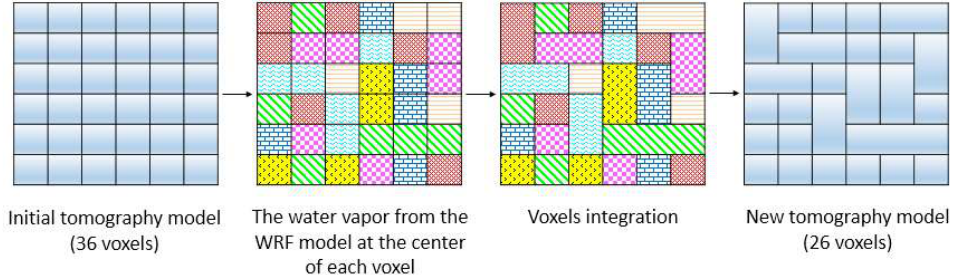
Figure 3. The process of performing the merging voxels based on the Weather Research and Forecasting (WRF) model .